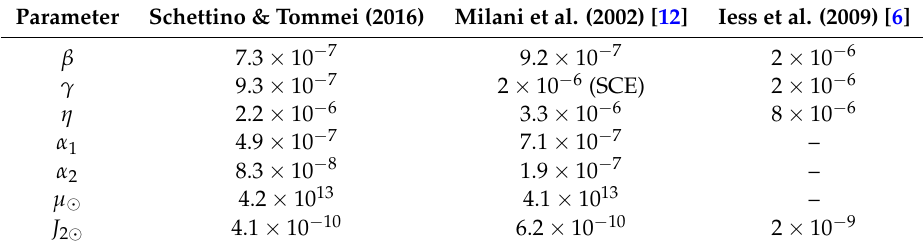
Table 3. Comparison between the results in Schettino & Tommei (2016) (this paper) and previous results of the relativity experiment ( µ (cid:12) in cm 3 /s 2